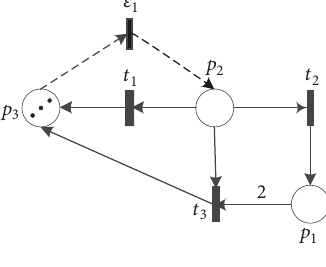
Figure 2: A Petri net with 𝑇 𝑢 = {𝜀 1